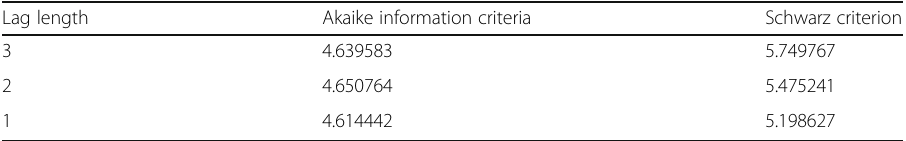
Table 4 Akaike and Schwarz lag length test Lag